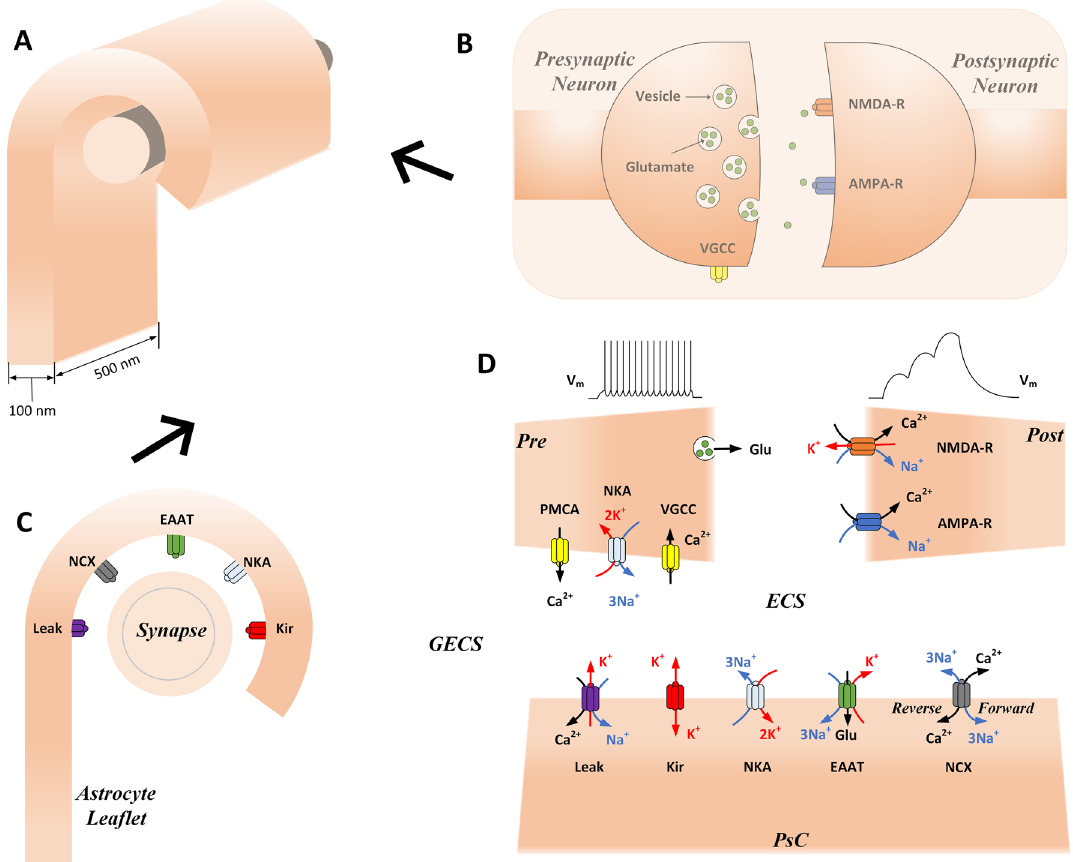
Figure 1. Schematic showing leaflet wrapping around synapse with the transmembrane channels, transporters and receptors used in the model. 3-D representation of an astrocyte leaflet enwrapping a neuronal synapse ( A ), with the right-side view ( B ) showing the main synaptic channels and receptors, and the front view ( C ) showing the astrocytic channels, transporters and exchangers. A schematic is given to show the signalling pathways and the compartments used in the model ( D ). Glu is released from the presynaptic terminal into the synaptic cleft and activates Glu receptors (AMPA-R and NMDA-R) on the postsynaptic dendritic spine. Glu also binds/ unbinds to/from EAATs which actively transport Glu away from the cleft into the PsC. K + is released into the cleft from the NMDA-R and through the astrocytic EAATs and K ir 4.1 channels. K + is taken up by the PsC through the NKA pump. K + flows away from the perisynaptic cradle in an extremely restricted manner along the ultra-thin astrocyte leaflet. Na + and Ca 2+ channels are also shown; astrocytic NCX and neuronal VGCC and plasma-membrane Ca 2+ -ATPase (PMCA). The NCX extrudes Ca 2+ under physiological conditions, however, the NCX can readily reverse to extrude Na + and uptake Ca 2+ . During an action potential, the VGCC opens to allow an influx of Ca 2+ which promotes Glu release. The PMCA acts much like the NKA, using the energy from ATP to maintain the Ca 2+ gradient. For clarity, only active channels are shown in the schematic, however for model completeness, neuronal passive transmembrane channels and extracellular diffusive currents are also included in the model which are not shown in the EAATs to clear 1 mM of Glu to be ∼ 33 ms. For each transport cycle, the EAAT co-transports 1Glu:3Na + :1H + and counter-transports 1 K + , generating a PsC Na + influx and K + efflux (it should be noted that the proposed model does not account for the H + fluxes or Cl − which is thermodynamically uncoupled from Glu transport). The background activity of the NKA increases due to the intracellular Na + and extracellular K + concentrations changing from the respective transmembrane fluxes. Separate to K + release through the EAAT, astrocytic K + efflux is achieved through K ir 4.1 channels densely populating perisynaptic membranes. The main synaptic K + efflux pathway in the model is the current generated through the postsynaptic NMDA-R. Hodgkin-Huxley type voltage-gated K + and Na + channels are included for the generation of the presynaptic action potential. However, we assume the presynaptic voltage-gated K + and Na + channels do not interact with the synapse ‘active zone’ 20 therefore we exclude the contribution of these channels to the respective ionic concentration in the ECS. To simulate the movement of the PsC during synaptic activation we carried out simulations for: (A) when the PsC is in intimate contact with the synapse and the ECS contains the cleft region only, (B) when a space exists between the PsC and the synapse such that the ECS volume is seven times that of the cleft and (C) when a space exists such that the ECS volume is approximately forty-nine times that of the cleft; Fig. 2 shows a schematic of